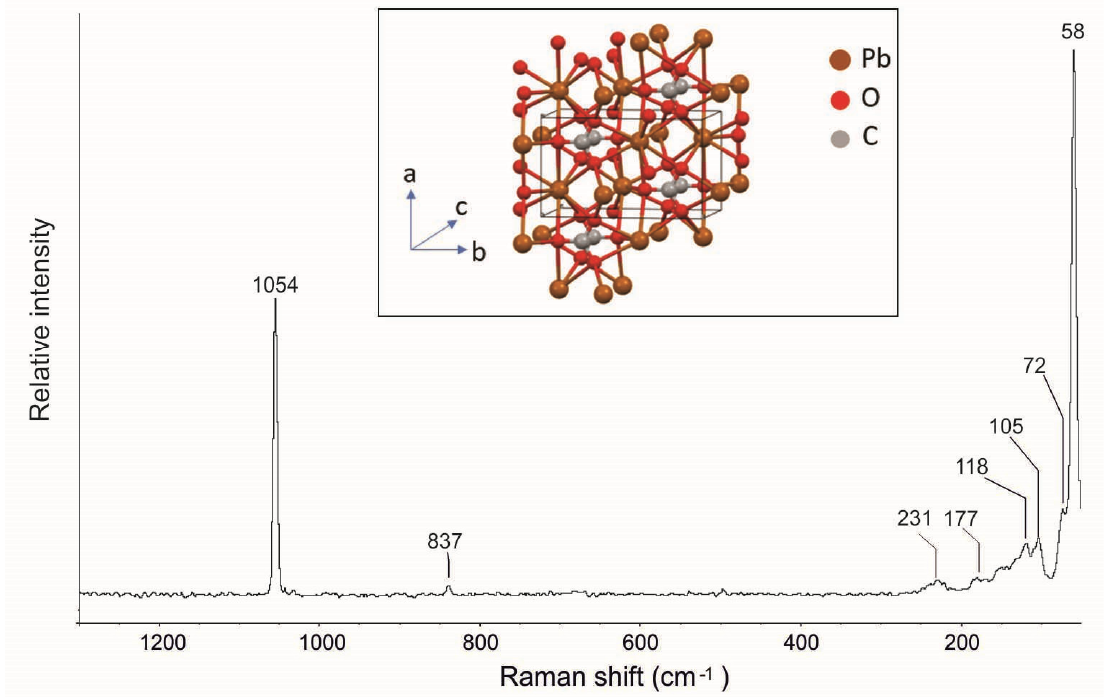
Figure 7. Raman spectrum of cerussite from the Mastricarro Barite Mine (Catanzaro, southern Italy). In the insert is the structure of the cerussite [44].